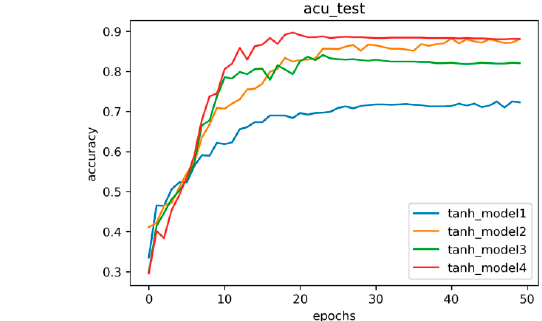
Figure 9. Comparison of the accuracy of different network depth models.